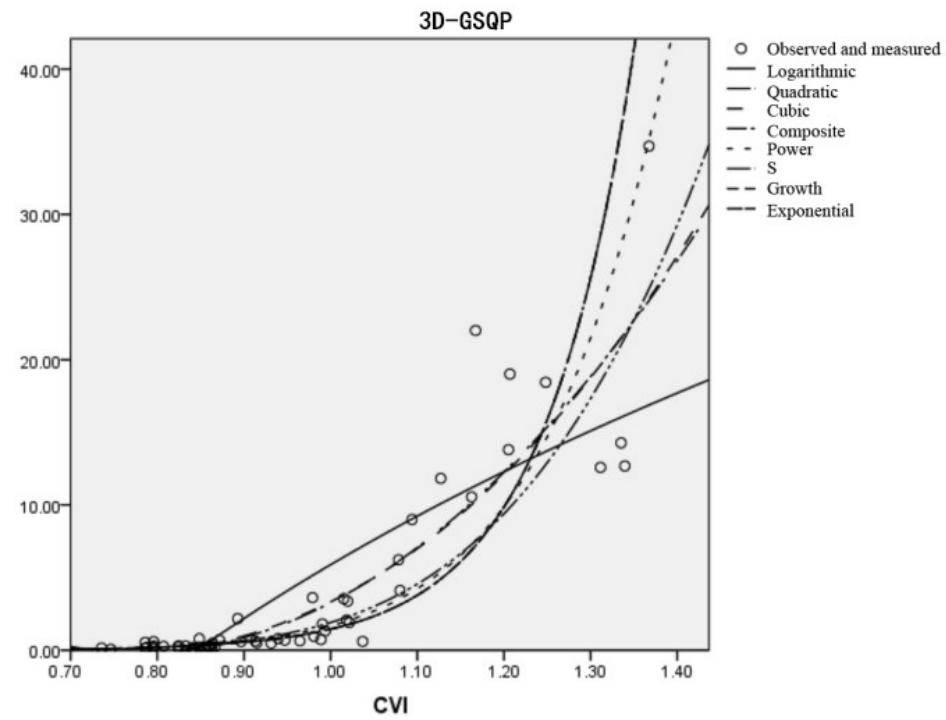
Figure 6. The results of the non-linear regression simulation of CVI and 3D-GSQP (m 3 /m 2 ). Table 5. Simulation results of the vegetation index and 3D-GSQP regression per unit area.